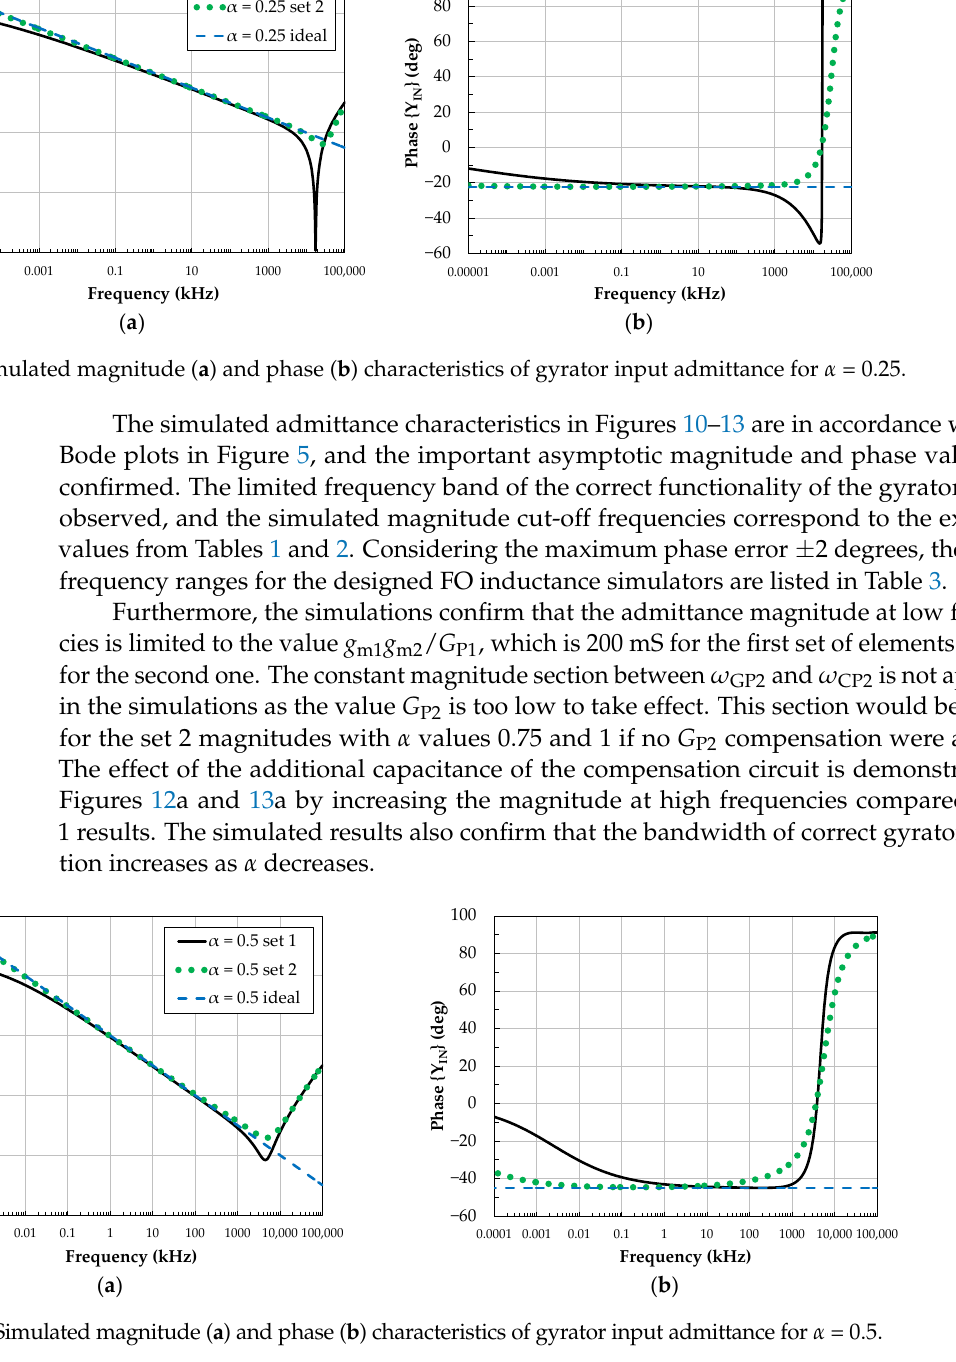
Figure 11. Simulated magnitude ( a ) and phase ( b ) characteristics of gyrator input admittance for α = 0.5.